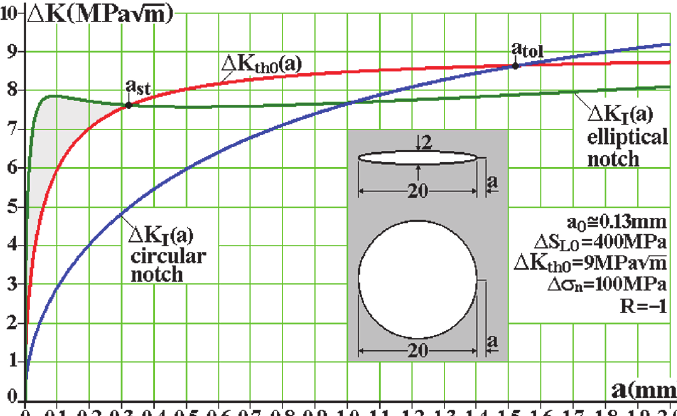
Figure 1: According to the short crack model, cracks should not initiate at the circular hole (which tolerates cracks a tol < 1.52mm ), while the crack that initiates at the elliptical hole tip should stop when reaching a size a st  0.33mm